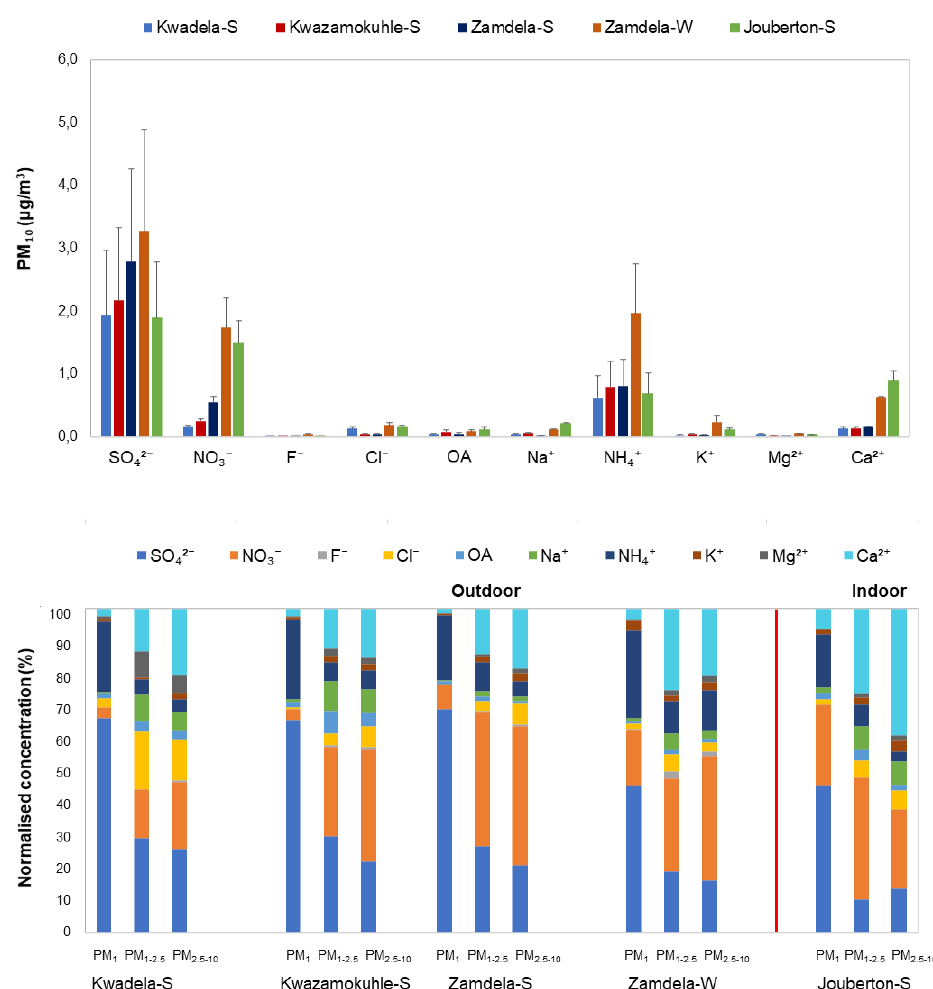
Figure 4. (a) Mean concentrations ( ± SD) of inorganic ionic species and water-soluble OAs in PM 10 , and (b) normalised concentration distributions of these species in PM 1 , PM 1 − 2 . 5 , and PM 2 . 5 − 10 at each site during respective sampling